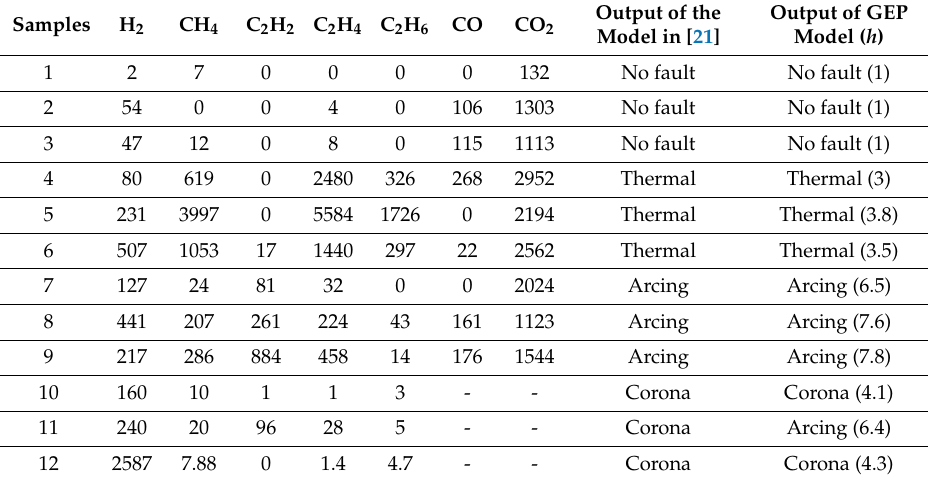
Table 4. Comparison of the GEP model with the fuzzy logic model in